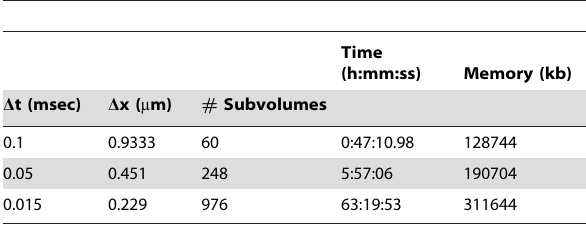
Table 4. Scalability of NeuroRD as a function of mesh size (space discretization) and time